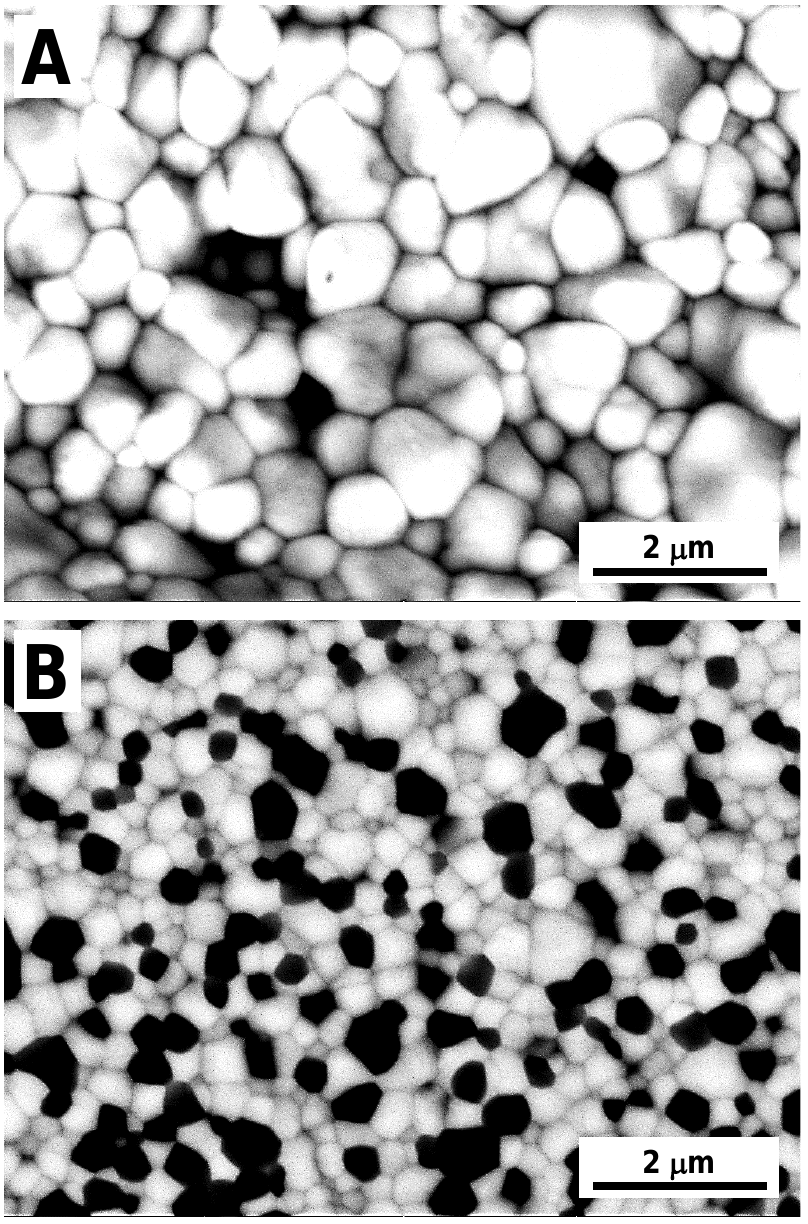
Figure 1. Backscattered SEM micrographs of ( A ) Y-TZP and ( B ) ATZ ceramics.